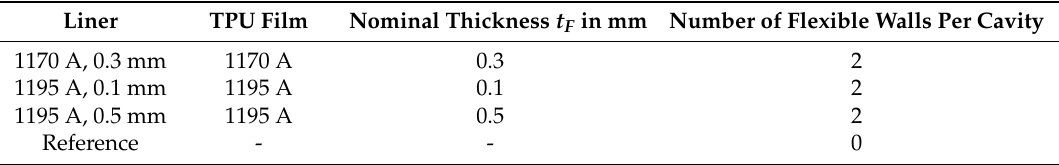
Table 2. Investigated acoustic liner configuration.